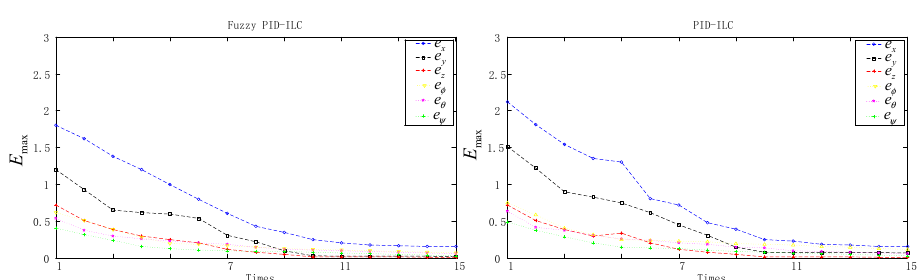
Figure 6. Trajectory of the quadrotor flight.